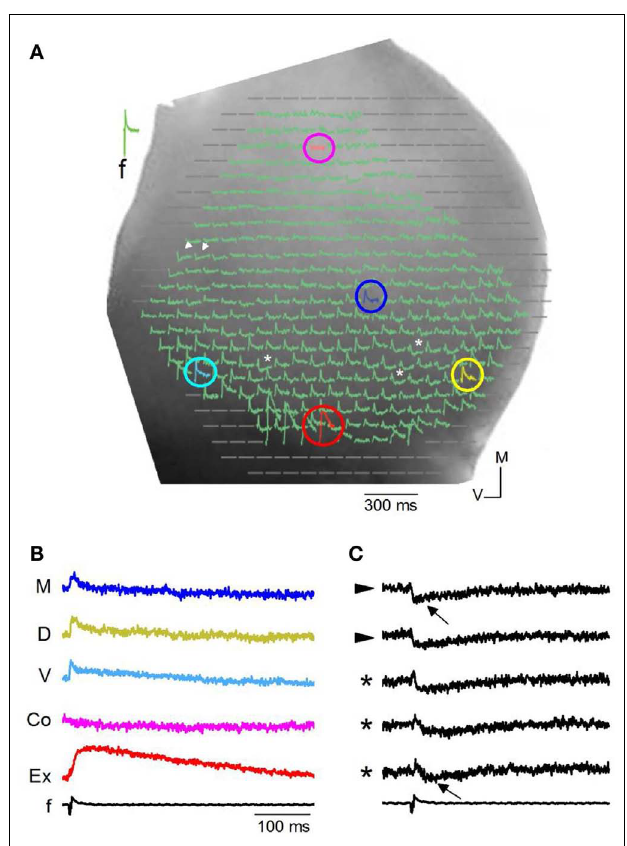
FIGURE 3 | Responses in a transverse slice evoked by minimal LL stimulation. (A) Image of one side of a rat IC seen through a 5 × objective with diode array superimposed. Colored circles, pixels with depolarizing responses. Pink, commissure; dark blue, medial ICC; yellow, dorsal ICC; red, external cortex; light blue, ventral ICC.White arrowheads, pixels with hyperpolarizing responses; asterisks, pixels with mixed de- and hyperpolarizing responses. (B) Traces of depolarizingVSD responses corresponding to the color-coded pixels in (A) . M, medial ICC; D, dorsal ICC; V, ventral ICC; Co, just lateral to the commissural region; Ex, External cortex; f , field recording. (C) Traces of hyperpolarizing and mixed de- and hyperpolarizingVSD responses corresponding respectively to the arrowheads and asterisks in (A) . Arrows, peak